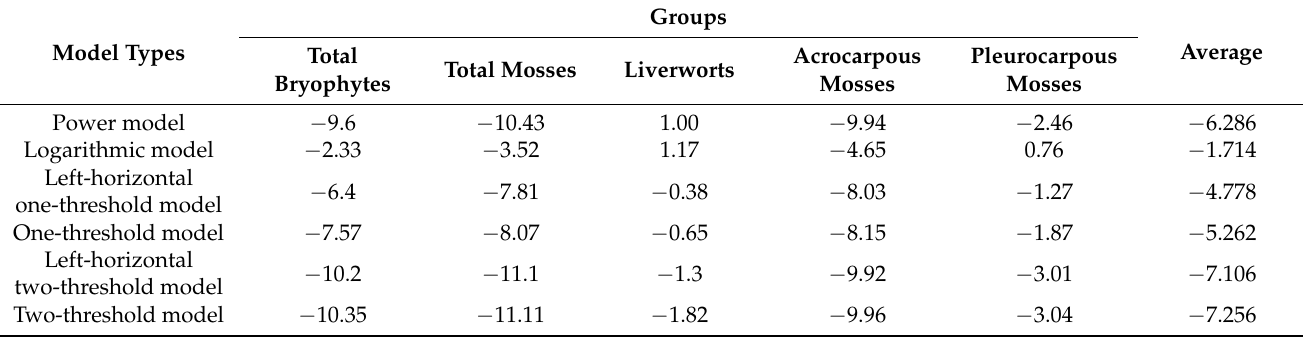
Table 3. The differences of the AICc values in SKRs minus those in